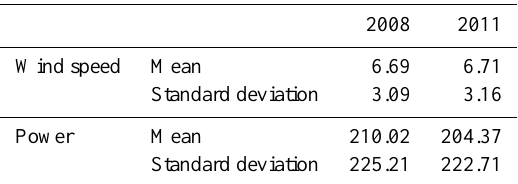
Table 1. Mean and standard deviation of measured wind speed (ms − 1 ) and power (kW) for the two